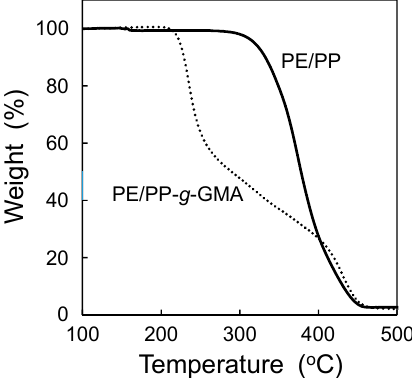
Figure 3. TGA curves for the PE / PP and PE / PP- g -GMA fabric under nitrogen.